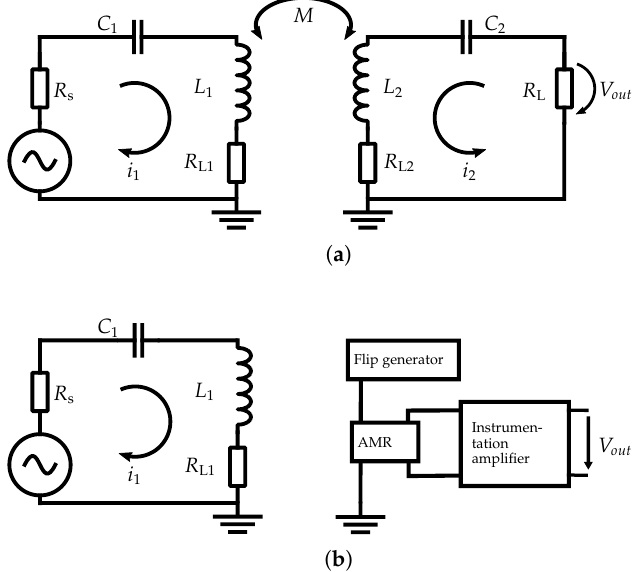
Figure 1. Conventional coil-to-coil topology ( a ) and coil-to-AMR topology under investigation ( b